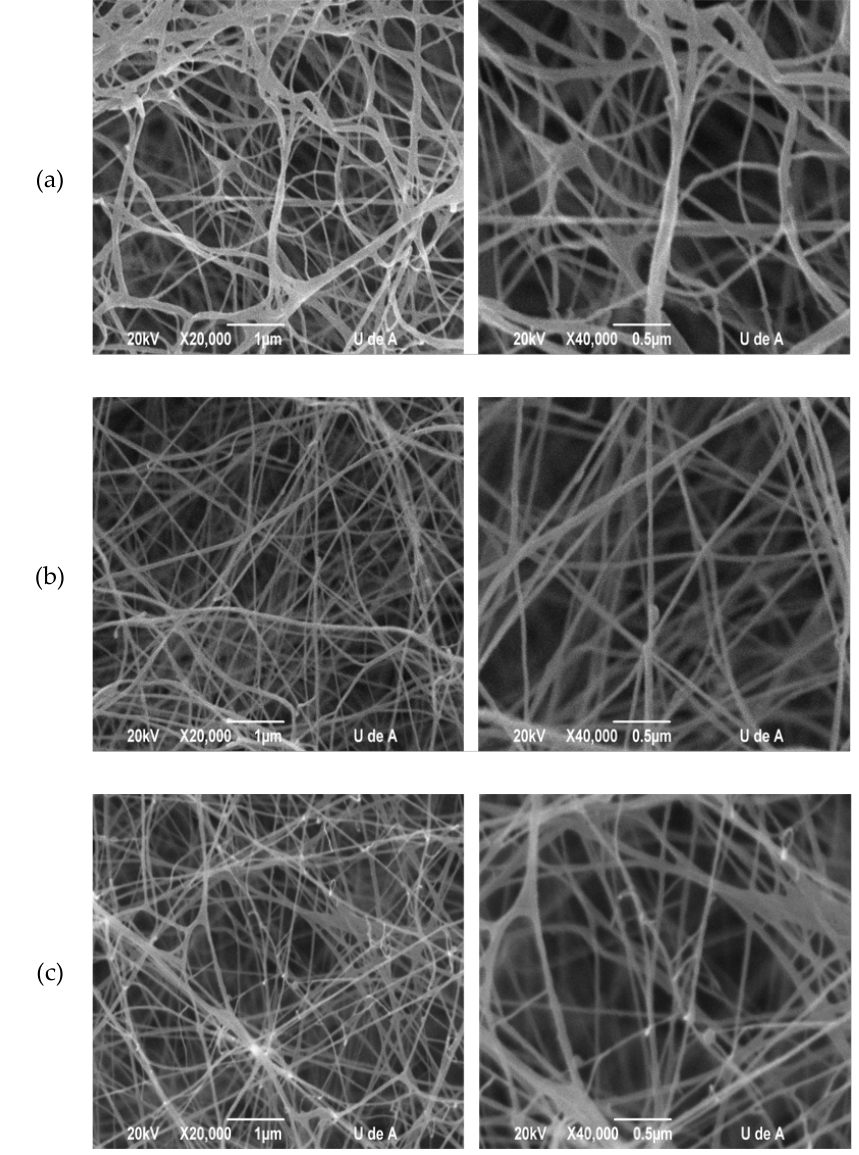
Figure 5. SEM micrograph of bacterial cellulose network obtained from different media: ( a ) Fructose; ( b ) Glucose; and ( c ) Sucrose. The left panel shows the 3D cellulose network at 20,000× and the right panel shows the 3D cellulose network at 40,000×.